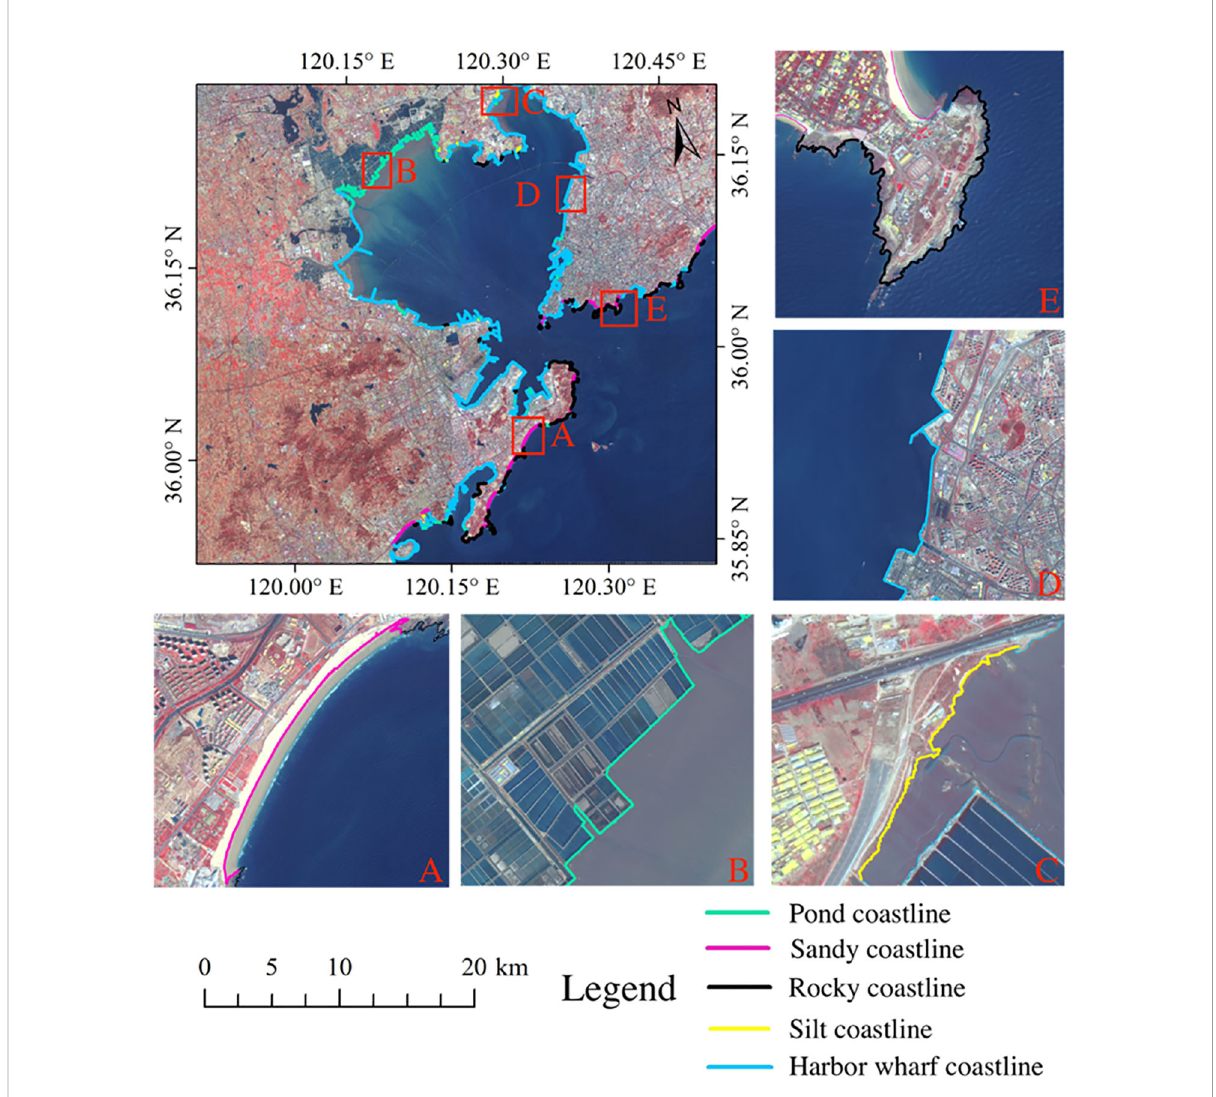
FIGURE 8 Automatic selection of various types of coastlines: From A-E represents the sandy coastline, pond coastline, silt coastline, harbor-wharf coastline, and rocky